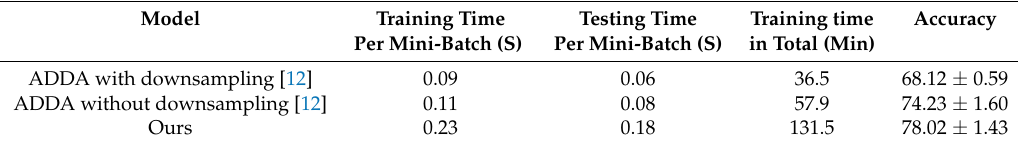
Figure 7. Visualization of locations selected on the non-cnetered unlabeled target domain datasets by source and target policy respectively. The green box is the first scale of glimpse and the red box represents the second scale. ( a ) Locations selected on the target datasets by source policy trained on the source domain; ( b ) Locations selected on the target domain by target domain policy learned after adversarial training. Table 2. Experimental results on unsupervised adaptation from the enlarged non-centered SVHN datasets to the enlarged non-centered MNIST